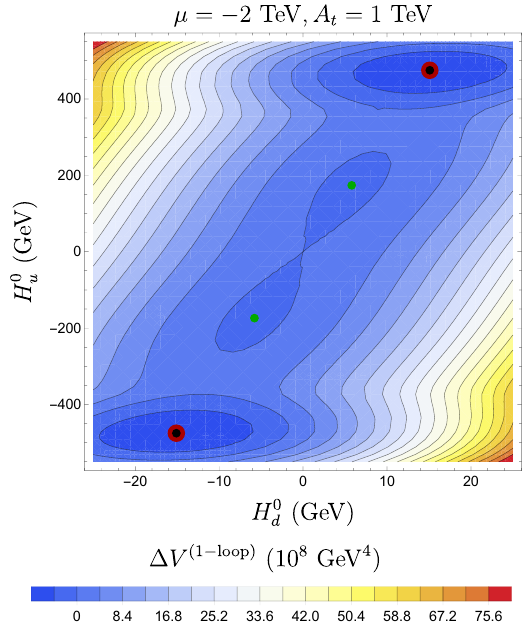
Figure 3 . Potential ((cid:1) V ) contours in the H 0 - H 0 plane showing the (equivalent) locations of the u d DSB vacuum (blobs in green) and the accompanying global CC minimum (blobs in black-within- red). The magnitudes of (cid:1) V can be estimated from the color-palette displayed underneath. The (cid:12)xed MSSM parameters ‘ (cid:22) ’ and A t are as indicated at the top of the plot. Other (cid:12)xed parameters are as in (cid:12)gure 1 with m = m = m = 1 TeV. See text for e Q 3 e U 3 e D 3